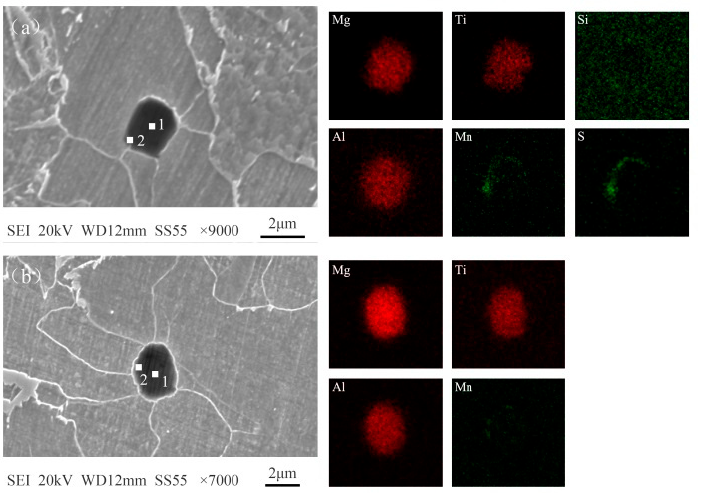
Figure 5. ( a , b ) The EAM-treated sample’s optical microstructure. ( c , d ) The non-treated sample’s optical microstructure.